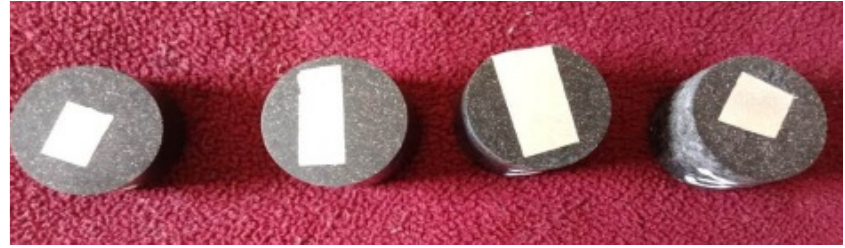
Figure 2. Composite specimens for microstructural analysis.